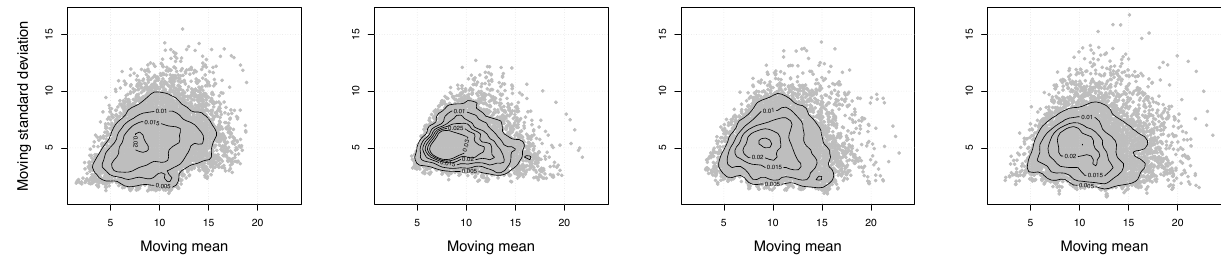
Figure 10. Moving standard deviation of the value { U t } against its moving mean at location 10. From left to right: data and simulation from the VAR(2), AP-MS-VAR C , and H-MS-VAR. Diff( u,v )